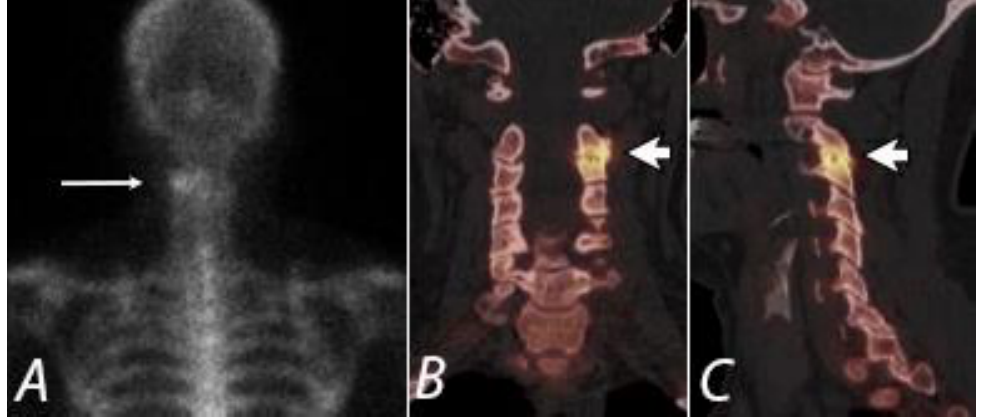
Figure 7. Posterior planar ( A ) (long white arrow), coronal ( B ), and sagittal ( C ) SPECT/CT images from a 99m Tc bisphosphonate bone scan of a 43 year old women with left neck pain. Marked radiopharmaceutical uptake corresponds to a severely degenerative left C2/3 facet joint (short white arrows), identifying a potentially targetable pain generator.